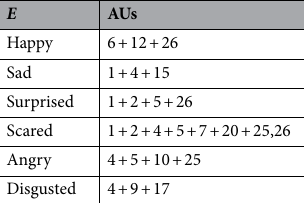
Table 1. The correspondence between basic expressions and